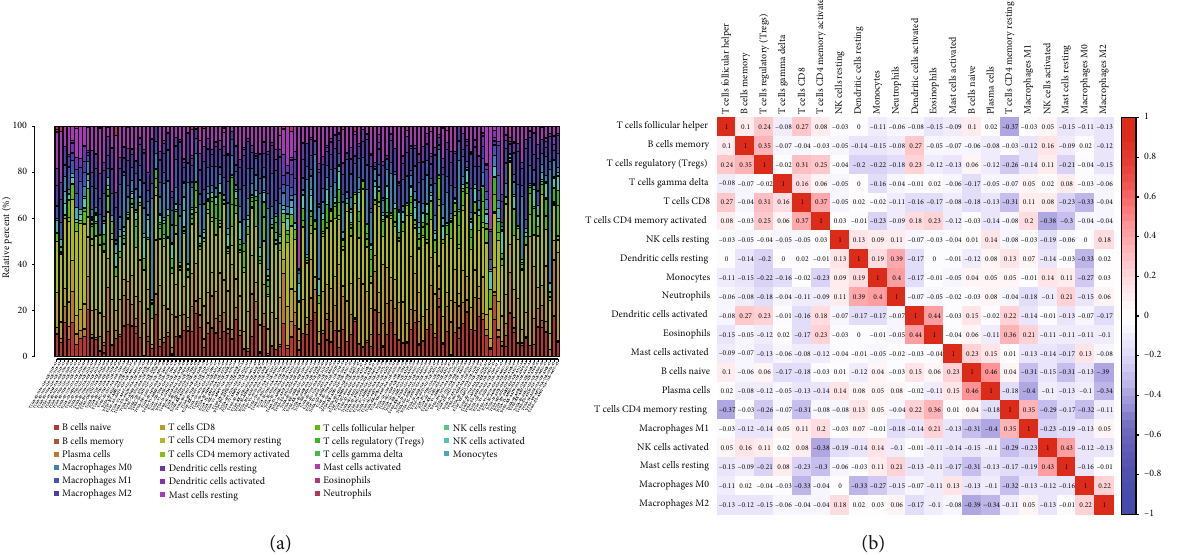
Figure 8: (a) The abundance of 22 in fi ltrating immunocyte subsets in tumorous and normal biopsies for TCGA cohorts computed via the CIBERSORT approach. (b) Diverse association features amongst 26 immunocyte subsets in PCa